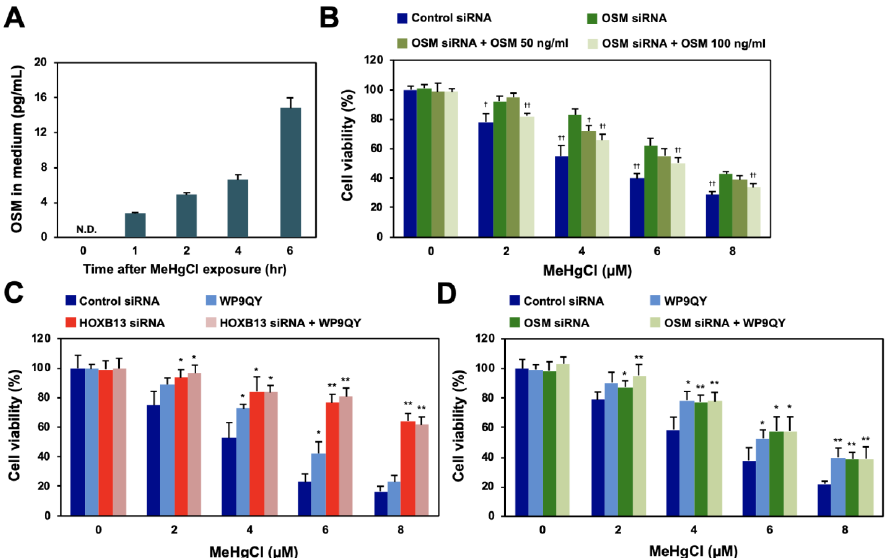
Figure 4. E ff ects of methylmercury on extracellular release of OSM and of the TNF receptor inhibitor on HOXB13 / OSM-mediated methylmercury toxicity. ( A ) HEK293 cells were treated with 20 µ M of methylmercuric chloride (MeHgCl) for the indicated time course, and OSM protein in the medium was measured by ELISA. ( B ) The cells were transfected with OSM siRNA (#2), and recombinant OSM was added to the medium. After incubation with MeHgCl for 24 h, cell viability was measured by alamarBlue assay. ( C , D ) The cells were transfected with HOXB13 siRNA (C) or OSM siRNA (D) for 48 h. WP9QY (10 µ M), a TNF, was added to the medium 90 min before exposure to MeHgCl for 24 h. No significant di ff erence was found between HOXB13 siRNA and HOXB13 siRNA + WP9QY or between OSM siRNA and OSM siRNA + WP9QY. All values are presented as mean ± S.D. of three individual experiments. * p < 0.05 vs. control siRNA, ** p < 0.01 vs. control siRNA. † p < 0.05 vs. MeHgCl-treated control siRNA, †† p < 0.01 vs. MeHgCl-treated control siRNA. N.D. indicates not